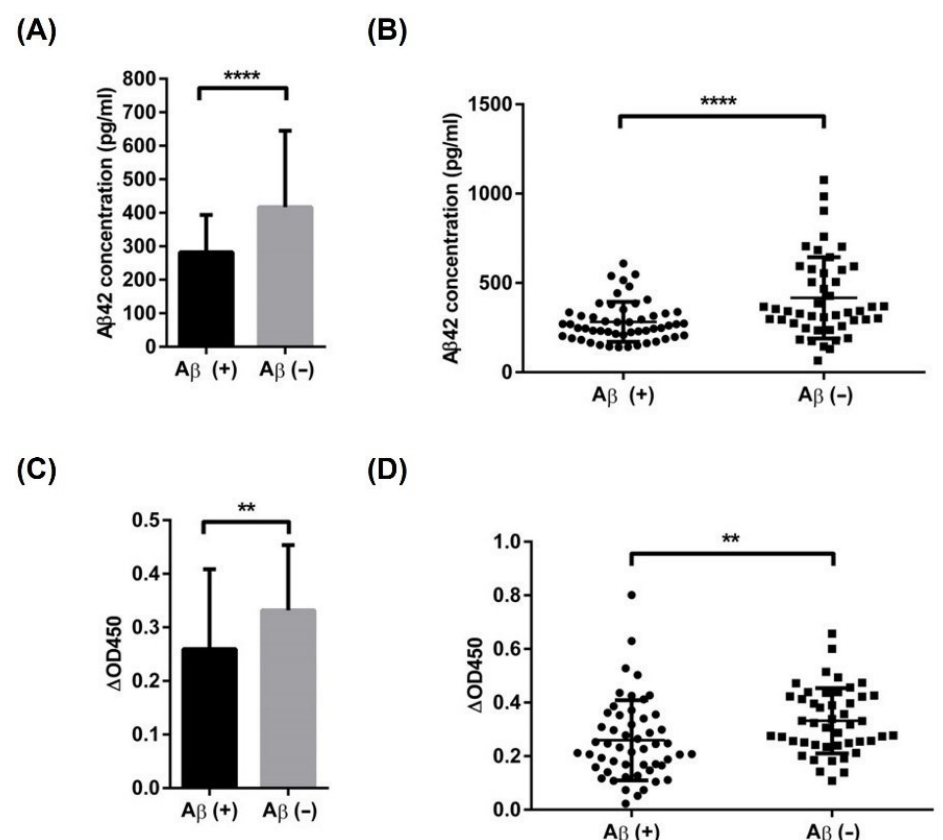
Figure 6. Gray-scale images of fluorine-18 [ 18 F]-florbetaben amyloid PET. ( A ) Typical amyloid PET image of BAPL3. An increased florbetaben tracer uptake was observed not only in the bilateral frontal and parietal cortex, but also in the ante- rior striatum. The differentiation of the cortical gray matter and subcortical white matter disappeared. ( B ) Typical amyloid PET image of BAPL1. The cortical–subcortical demarcation was well maintained, and no florbetaben tracer uptake was observed in the cerebral cortex.